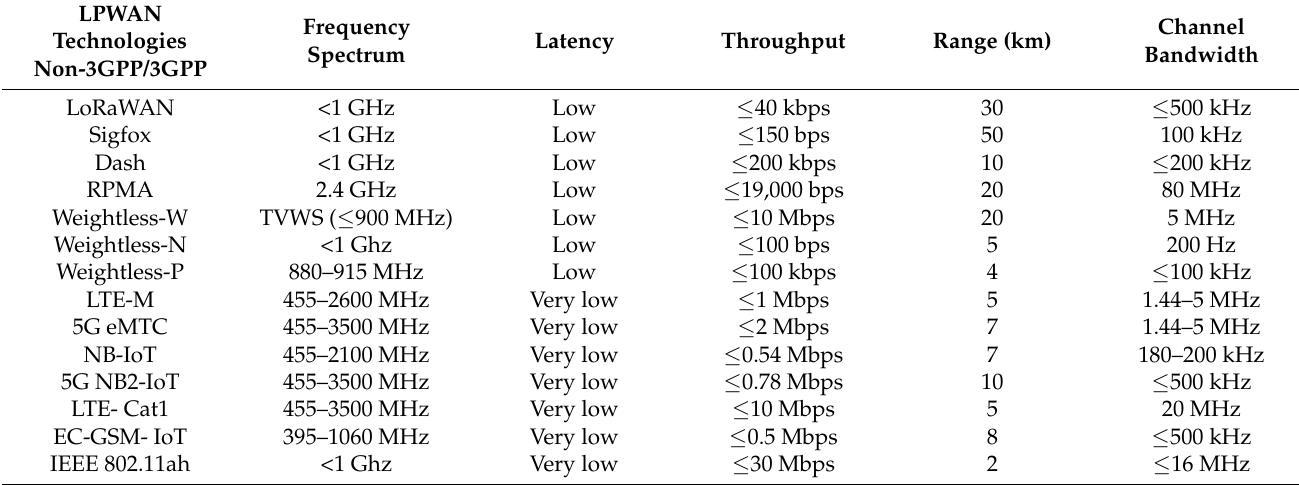
Table 2. LPWAN Technologies Comparisons.